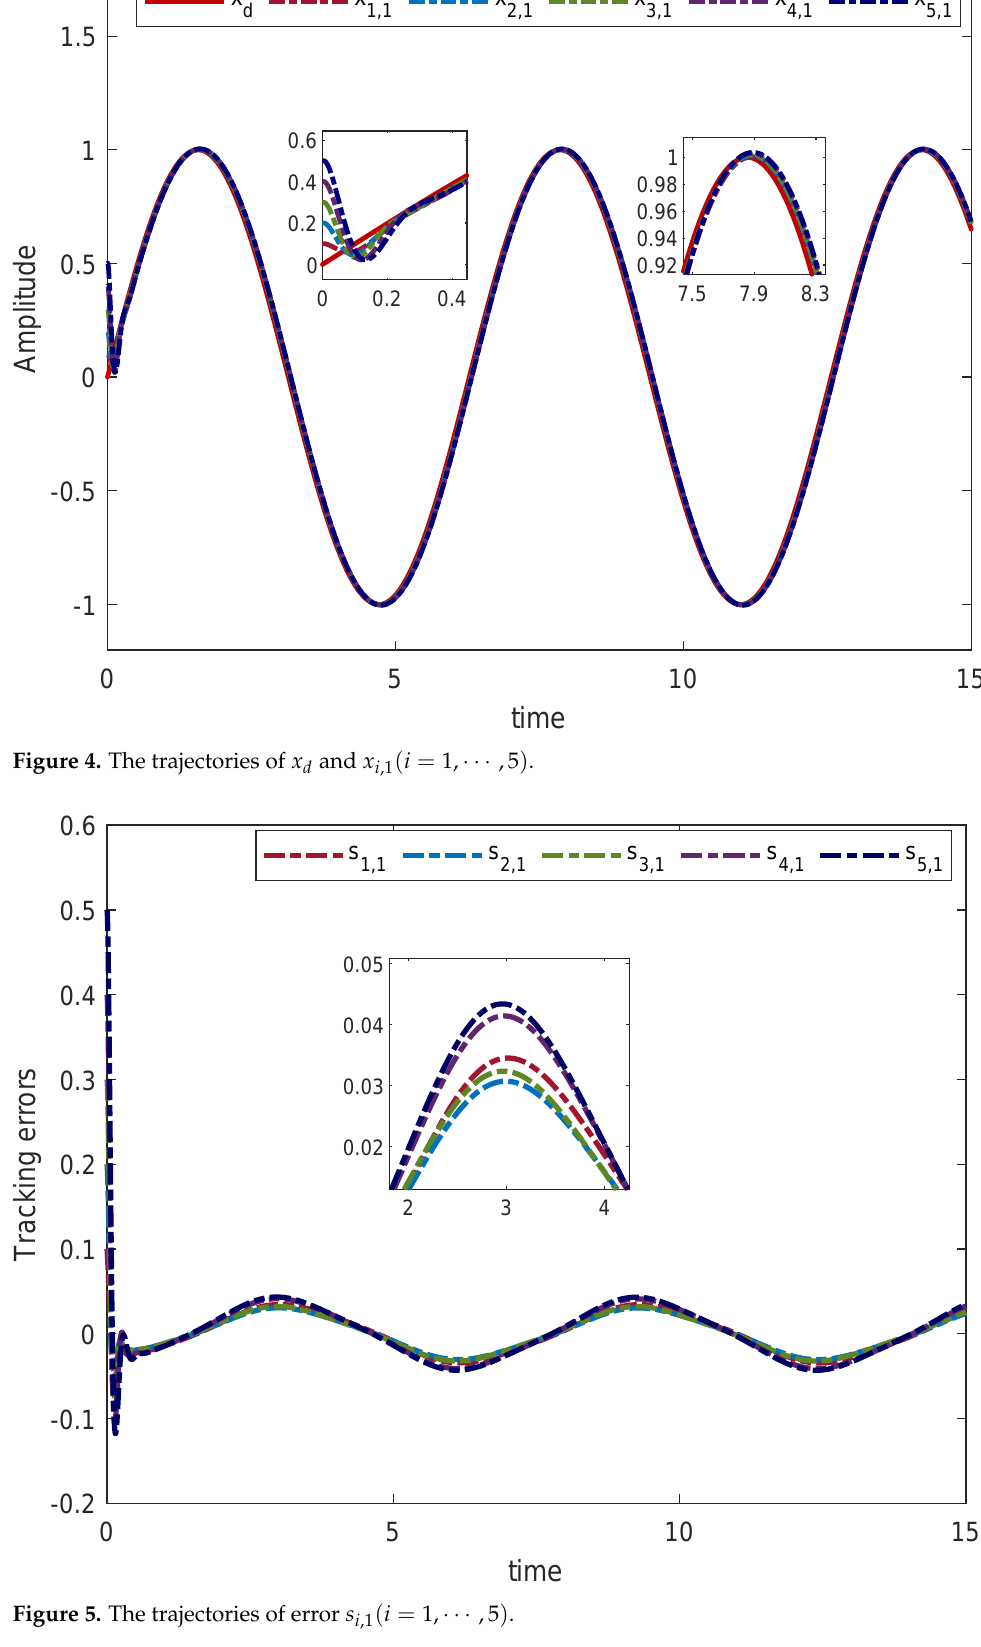
Figure 5. The trajectories of error s i ,1 ( i = 1, · · · ,5 )